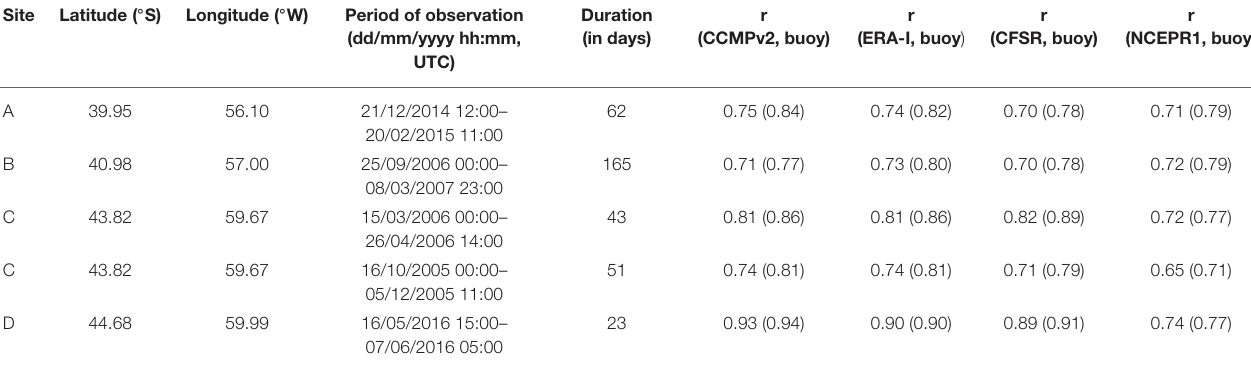
TABLE 2 | Positions, period of observation and duration of the 10 m wind records (columns 1 to 5) from meteorological buoys. Site Latitude ( ◦ S) Longitude ( ◦ W) Period of observation (dd/mm/yyyy